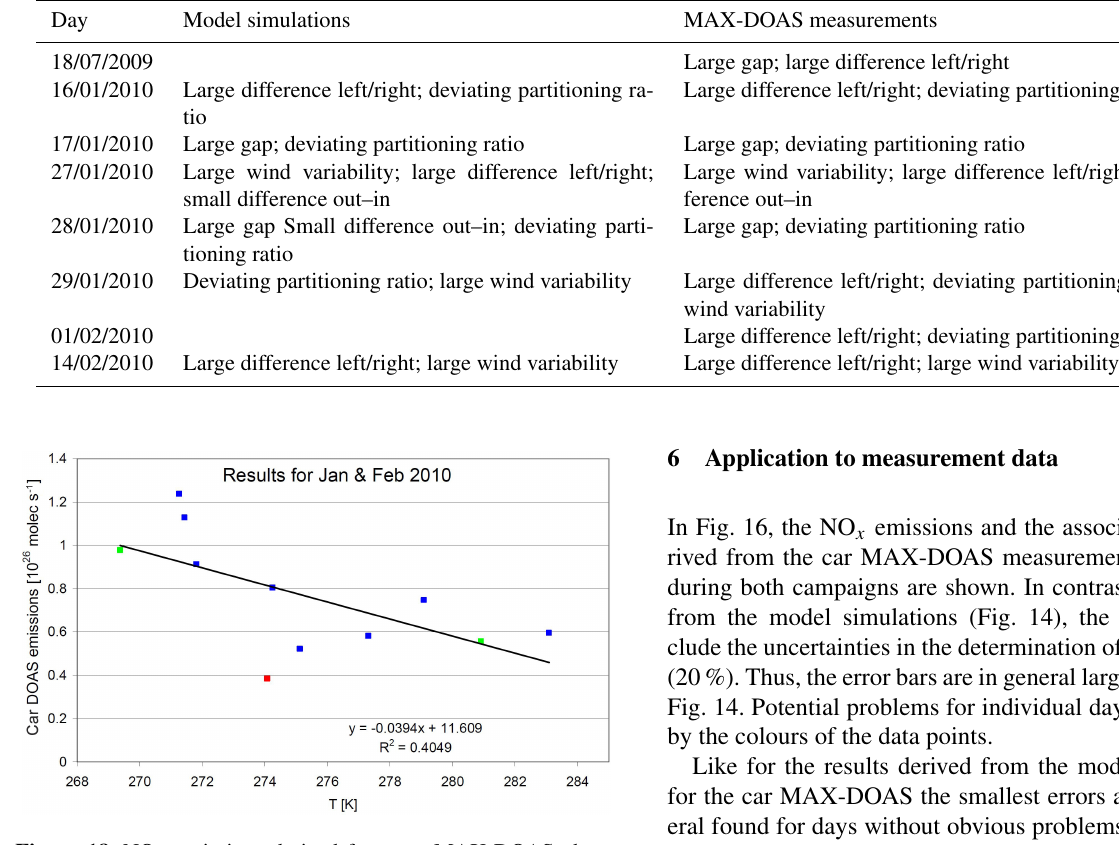
Figure 18. NO x emissions derived from car MAX-DOAS obser- vations in winter as a function of the surface temperature (average temperature taken from the model simulations during the period of the car MAX-DOAS measurements). Green and red dots mark re- sults for Saturdays and Sundays,